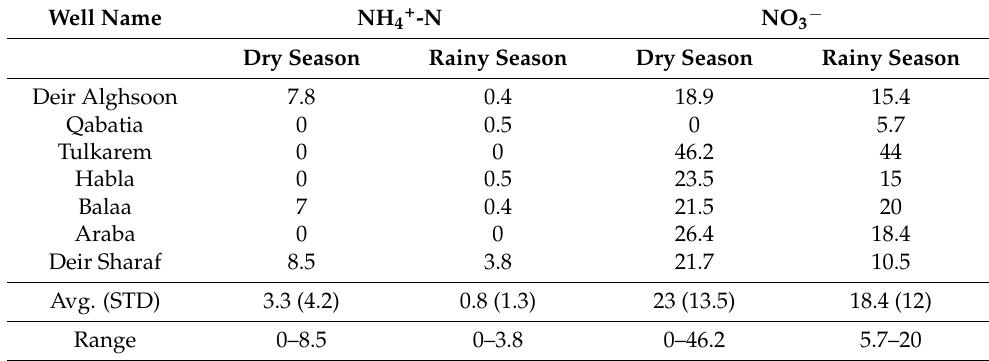
Table 4. Ammonium and nitrate concentration in selected wells during dry and wet